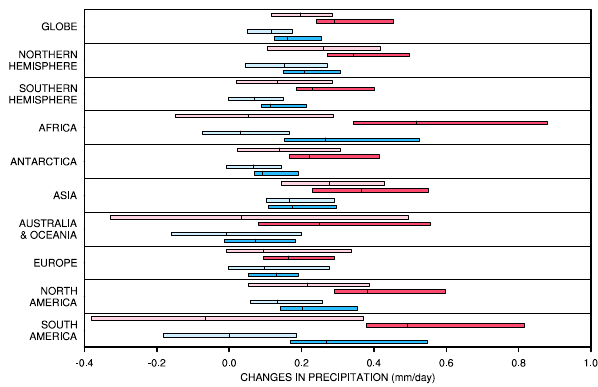
Fig. 20. Same as Fig. 19 but for changes in precipitation (mmday − 1